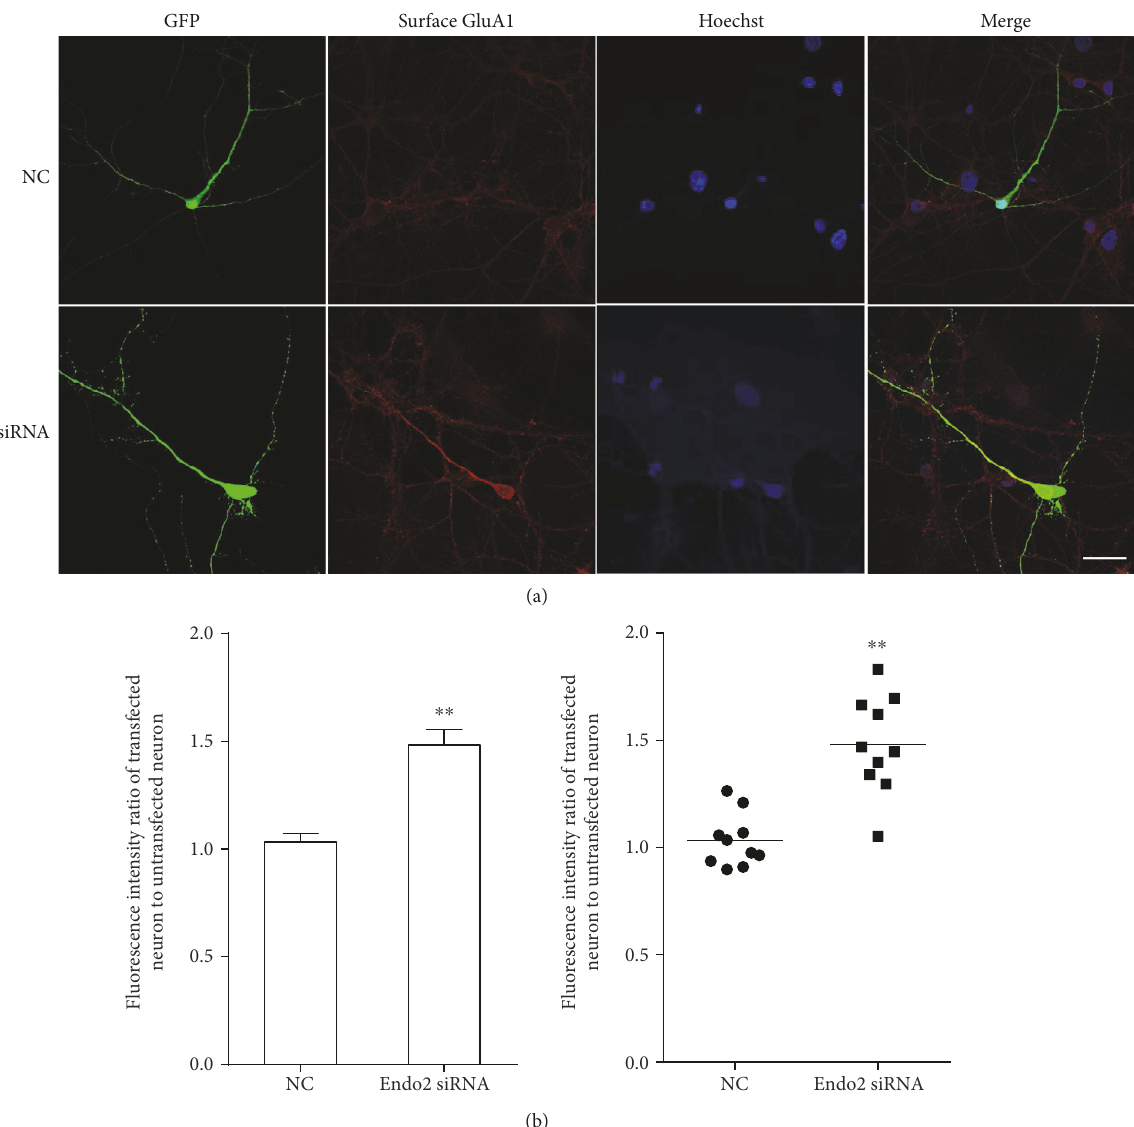
Figure 6: The expression levels of surface GluA1 in endophilin2 knockdown neurons treated by oligomeric A β . (a) Hippocampal cultured neurons transfected with NC and Endo2 siRNA immunostained with surface GluA1. Scale bar is 20 μ m. (b) The fl uorescence intensity of surface GluA1 in cytoplasm transfected with Endo2 siRNA or NC was normalized to neighboring untransfected neurons. n = 10 cells, 3 cultures from 6 SD rats, ∗∗ P < 0 005